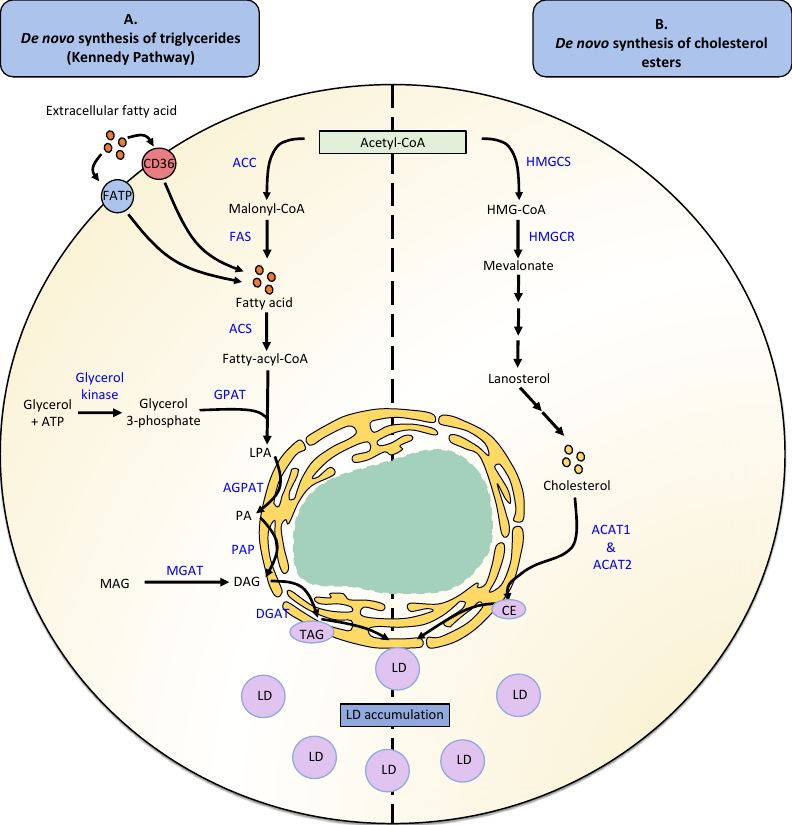
Figure 1. Lipid droplet biogenesis. ( A ) De novo synthesis of triglycerides in a typical human cell resented as a light ‐ yellow circle. ( B ) De novo synthesis of cholesterol esters. Enzyme names are written in blue. Chemical transformations involving multiple reactions are depicted as a sequence of three arrows. Abbreviations: CoA: coenzyme A; HMG: hydroxymethylglutaryl; FAS: fatty acid syn ‐ thase; ACS: Acyl ‐ CoA synthetase; PA: phosphatidic acid; GPAT: glycerol ‐ 3 ‐ phosphate O ‐ acyltransferase; LPA: lysophosphatidic acid; AGPAT: 1 ‐ acylglycerol ‐ 3 ‐ phosphate O ‐ acyltransferase; PAP: phosphatidic acid phosphatase; MAG: monoacylglycerol; MGAT: Monoacylglycerol acyltransferase; DGAT: diacylglycerol O ‐ acyltransferases; HMGCS: 3 ‐ hydroxy ‐ 3 ‐ methylglutaryl ‐ coenzyme A